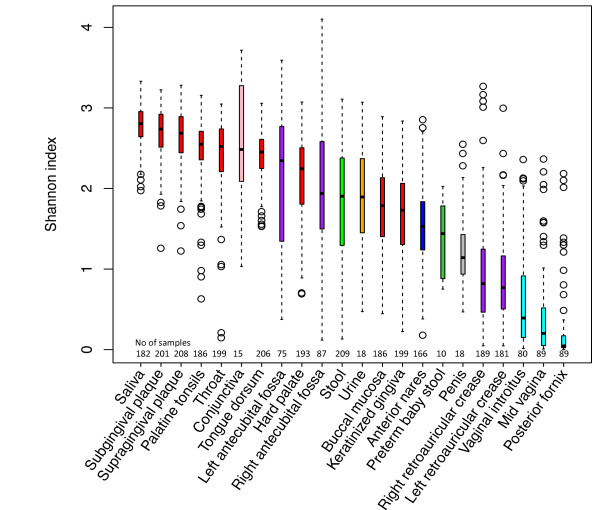
Shannon diversity comparisons of 22 habitats. One thousand reads were rarefied from each sample. The boxplot shows the minimum, 25th percentile, median, 75th percentile, and the maximum of the data from bottom to top. Oral habitats in general have more even bacterial communities, and vaginal habitats have the lowest Shannon diversity.